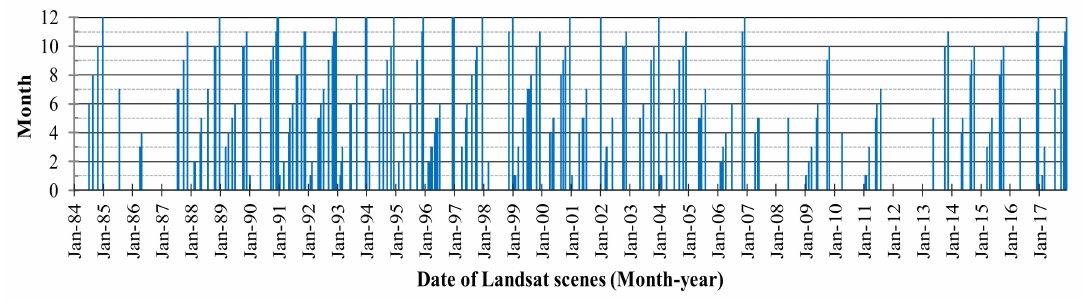
Figure 2. Seasonal distribution of collected Landsat scenes from 1984 to